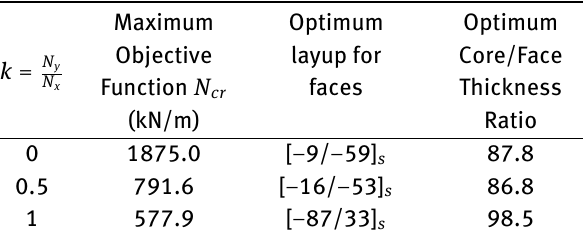
Table 4: Optimisation of a simply supported sandwich cylindrical panel with isotropic core.